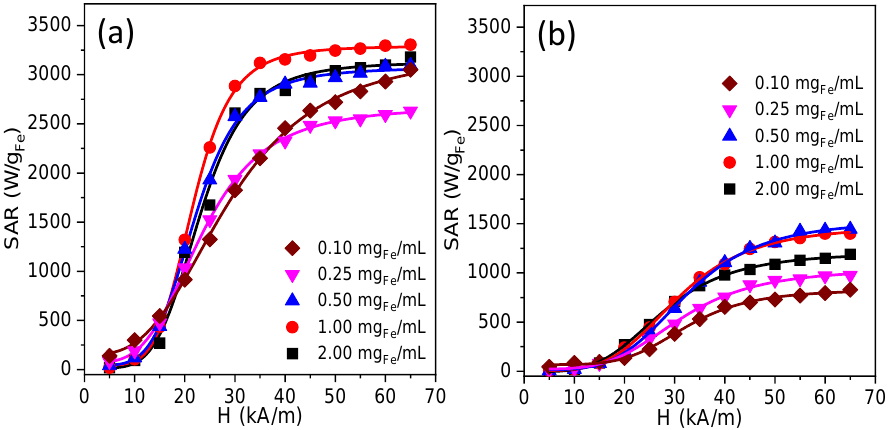
Figure 1. SAR dependence on the H for different concentrations of the Zn ferrites dispersed in ( a ) water and ( b ) PEG 8K. The lines are the best fits obtained by using the logistic function.